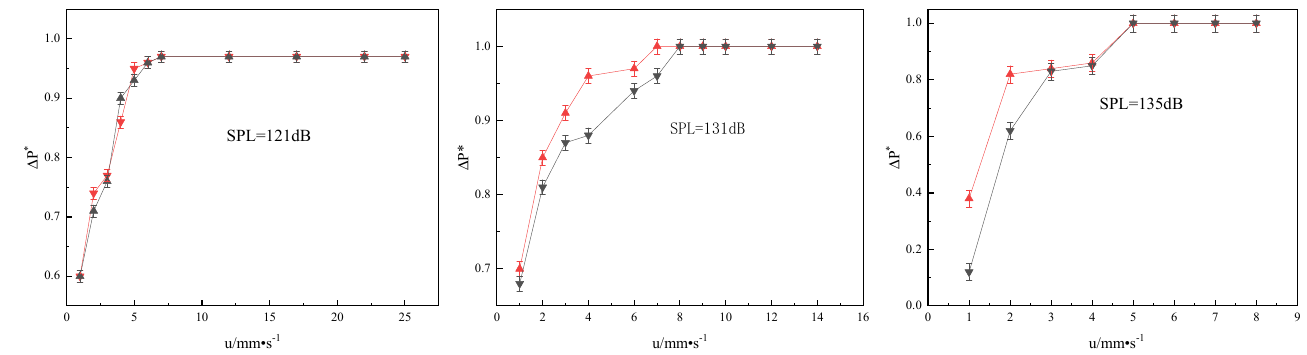
Figure 11. Bed pressure drop–velocity curve under different sound pressures.